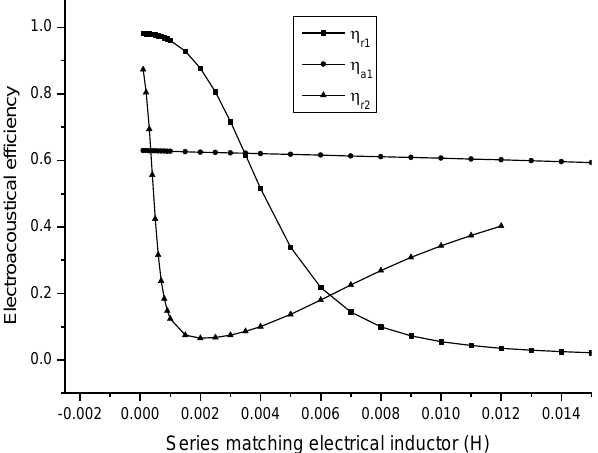
Figure 11. Dependency of the electro-acoustic efficiency on the series matching inductor.